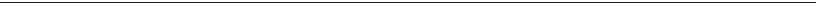
FIGURE1 removed. Step 3 : For each study, 6 volume renderings with 6 view angles rotated every 60 degrees around the long axis were generated. The mid-cavity AHA segment in the foreground was noted under each view. Step 4 : For each view angle, a volume rendering video was created to show the wall motion across one heartbeat. Five systolic frames in VR video were presented. ED, end-diastole; ES, end-systole. Data Labeling: Step a: LV segmentation. LV, green. Step b : Quantitative RS CT was calculated for each voxel. Step c : The voxel-wise RS CT map was binarized and projected onto the pixels in the VR video. See Supplementary Material 2 for more details. In rendered RS CT map, the pixels with RS CT ≥ − 0.20 (abnormal wall motion) were labeled as red and those with RS CT < − 0.20 (normal) were labeled as black. Step d : a video was labeled as abnormal if > 35% endocardial surface has RS CT ≥ − 0.20 (red pixels).